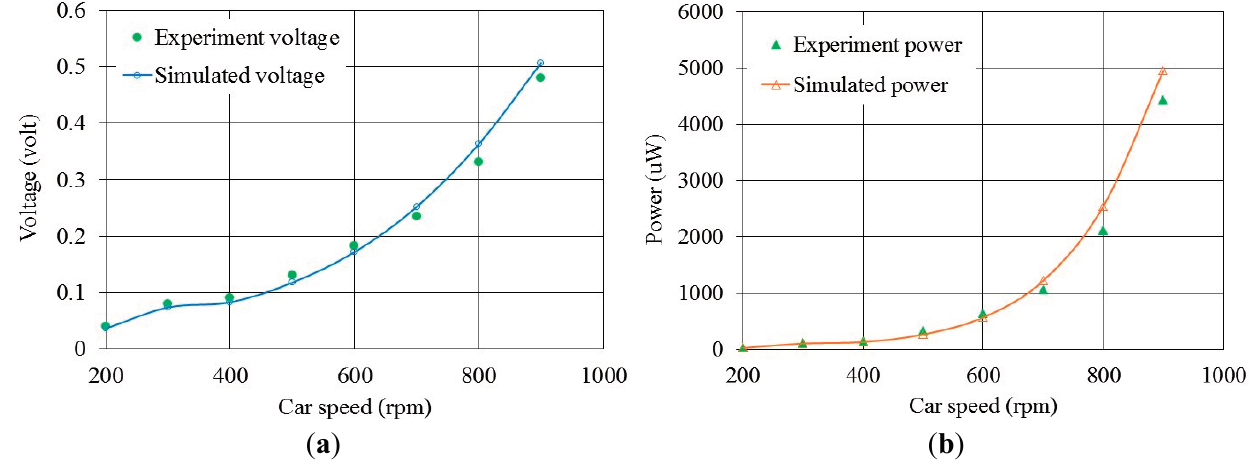
Figure 10. Power generation and output voltage (RMS value). ( a ) Output voltage. ( b ) Output